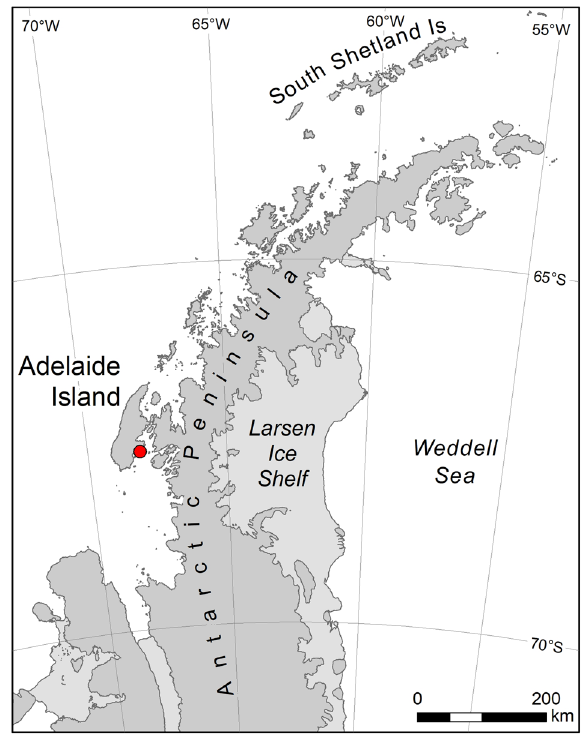
Fig. 1 Location of deployment site in Antarctica. Study area. Red dot within this is study site adjacent to Rothera Research